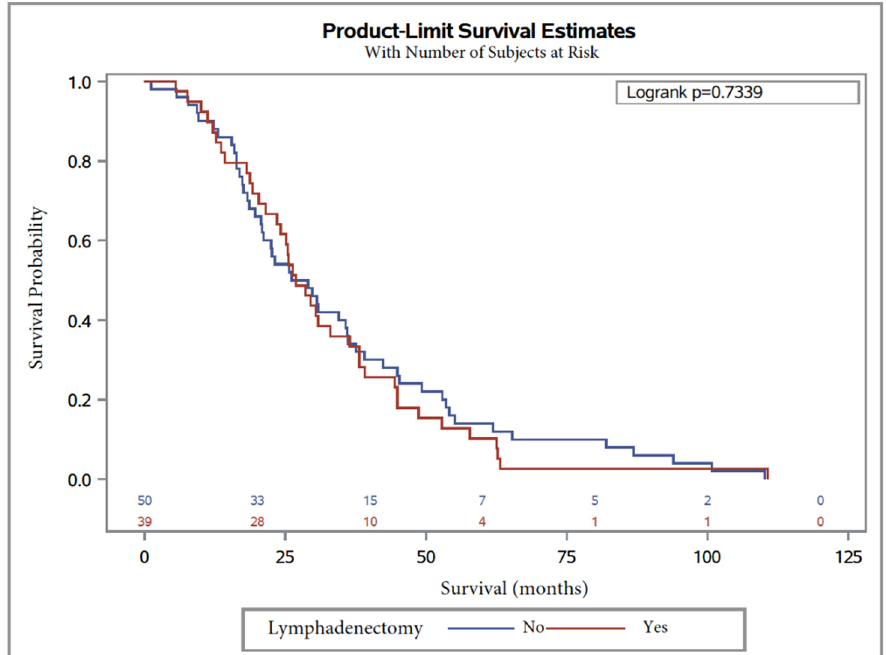
Figure 2. Overall survival in patients with serous ovarian carcinoma after NAC with or without lymphadenectomy. Table 5. Cox regression analysis for progression-free survival (PFS).